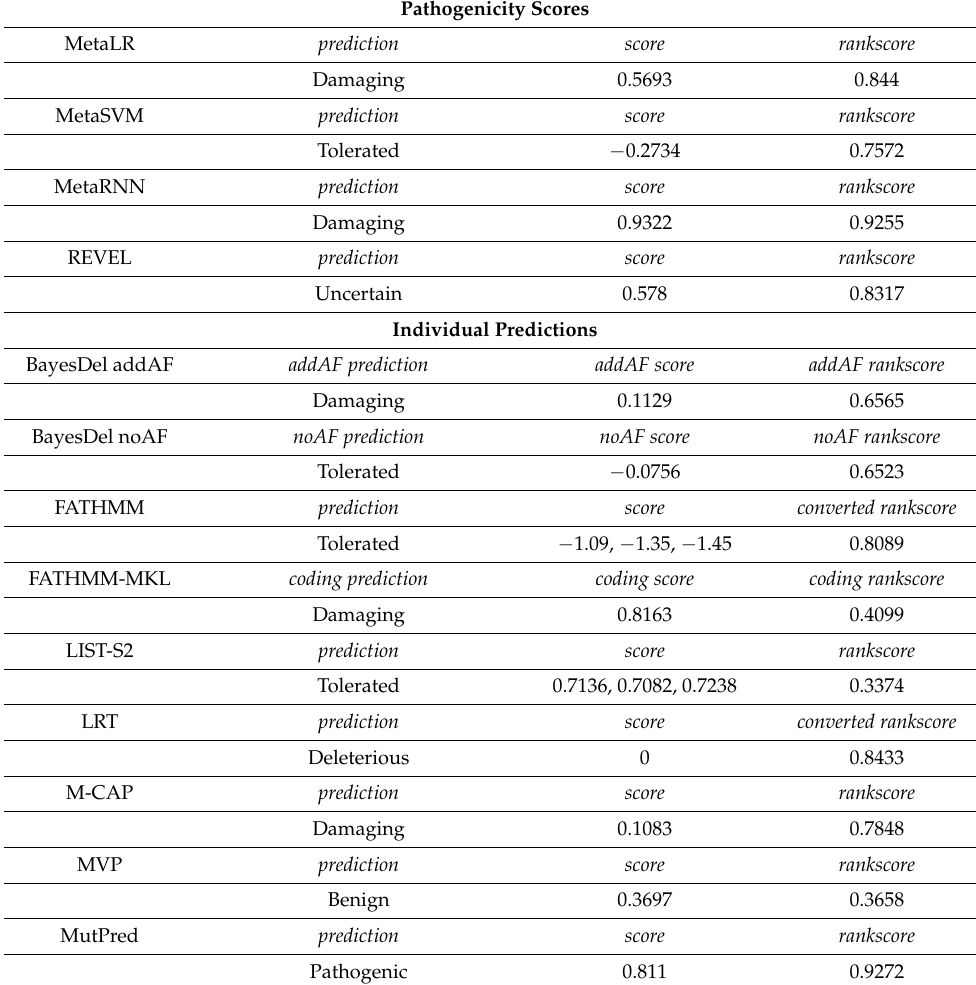
Table 3. In silico evaluation of the RADX variant